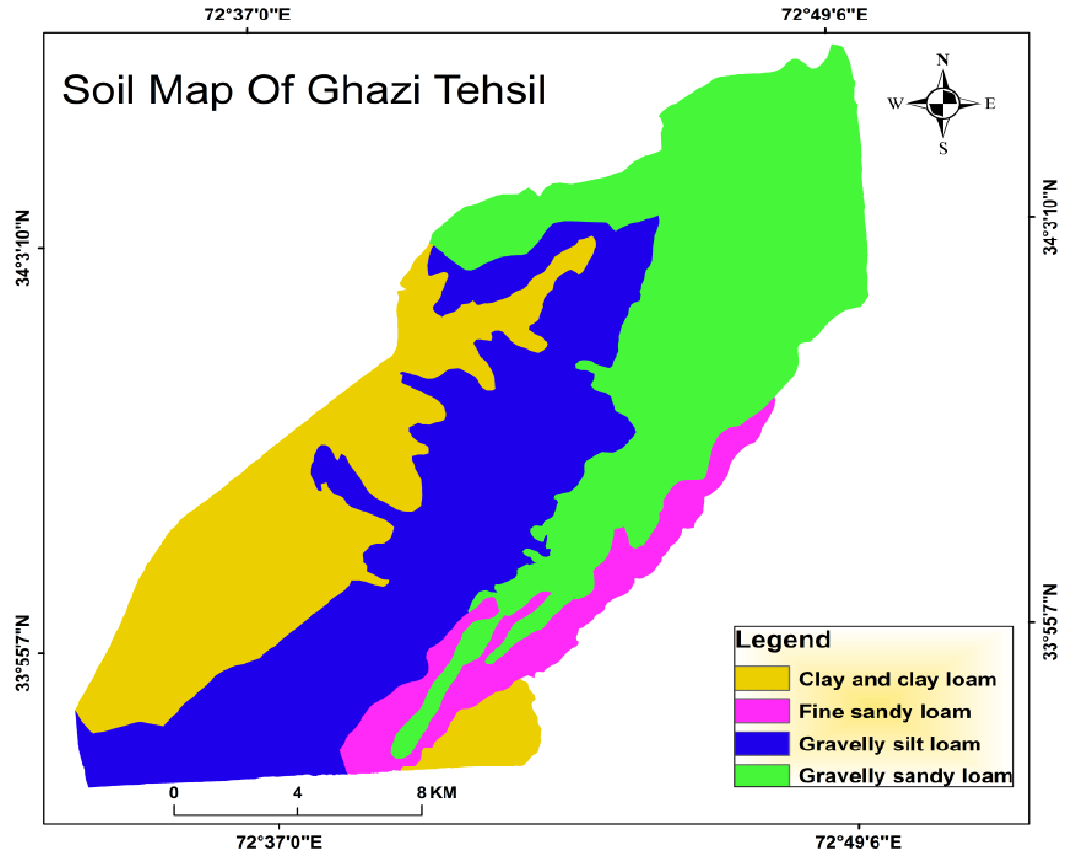
Figure 5. Hydrological soil group (HSG) of the study area showing soils of different major textures.